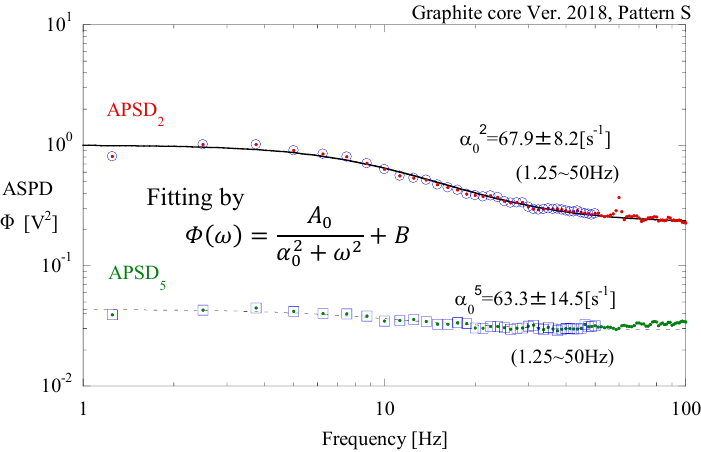
Figure 3. Auto - power spectral density from B2 and B5 in rod pattern S (critical